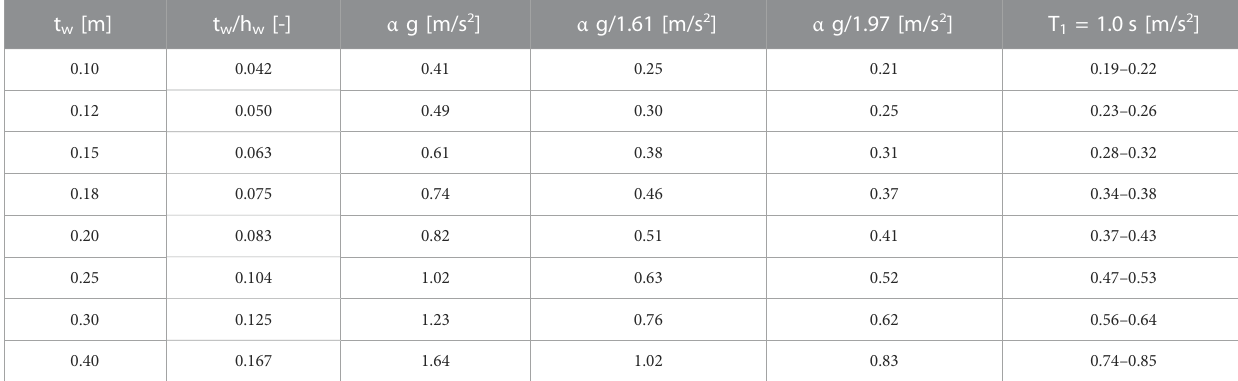
TABLE 6 Results for a wall height of 2.4 m situated in the upper fl oors in case of soil class C and a period of the primary structure of T 1 = 1.0 s. The considered ultimate ground accelerations for damping ratio between 3% and 5% (last row) compare well with the reduced static stability